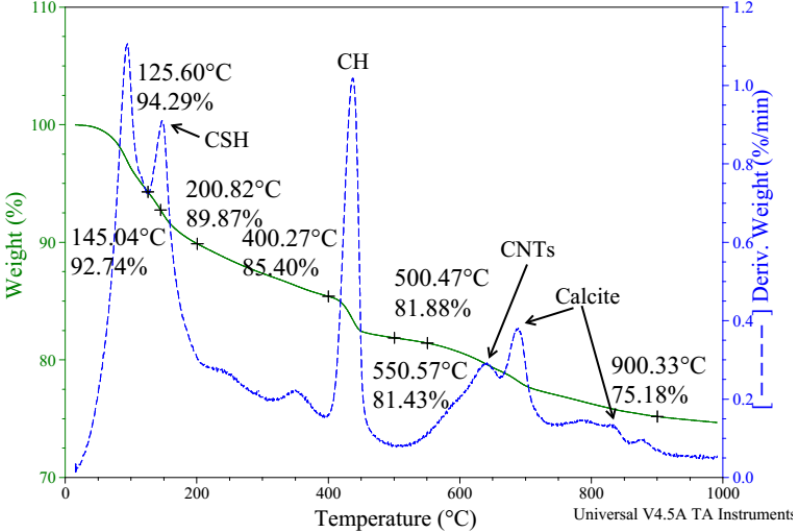
Figure 18. TGA/DTG observations of CNT-TEOS/PVP NFs-blended cement paste.